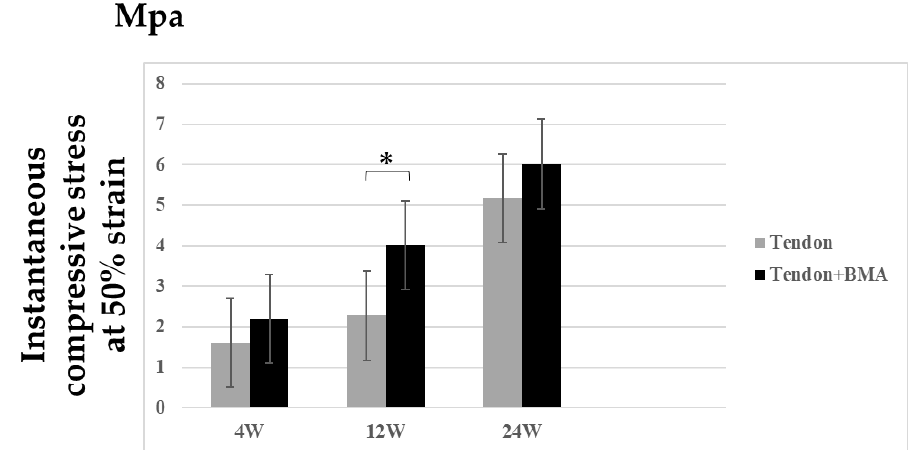
Figure 7. Biomechanical analysis of regenerated meniscus at 4, 12, and 24 weeks post-transplantation in tendon and tendon + BMA groups ( n = 6, * p < 0.05). Values are presented as mean ± SD. The compressive stress of the regenerated meniscus in the tendon + BMA group was significantly higher than that in the tendon group at 12 weeks postoperatively.